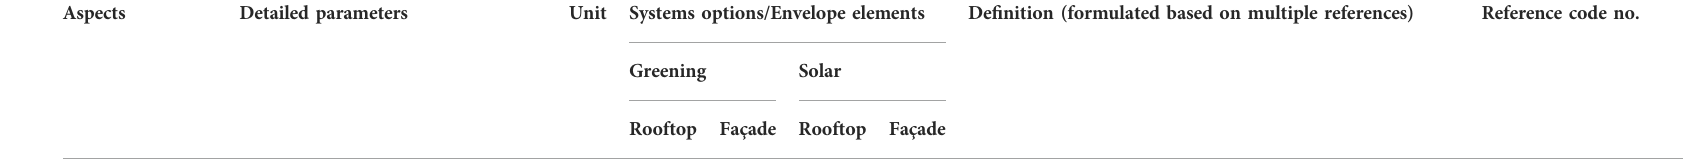
TABLE2Pillar2ofperformanceaspectsforPBSsImplementationmappedagainstsystems ’ options(greeningorsolar)ondifferentenvelopeelements(rooftoporfaçade).Detailedaspectsandparameters were de fi ned for each category, the measurement units, and the de fi nitions are outlined as well. DLI, Daily Light Integral; LAI, Leaf Area Index; PAR, Photosynthetically Active Radiation; CWR, Crop Water Requirements; PVs, Photovoltaic panels; ETTV, Envelope Thermal Transfer Value.